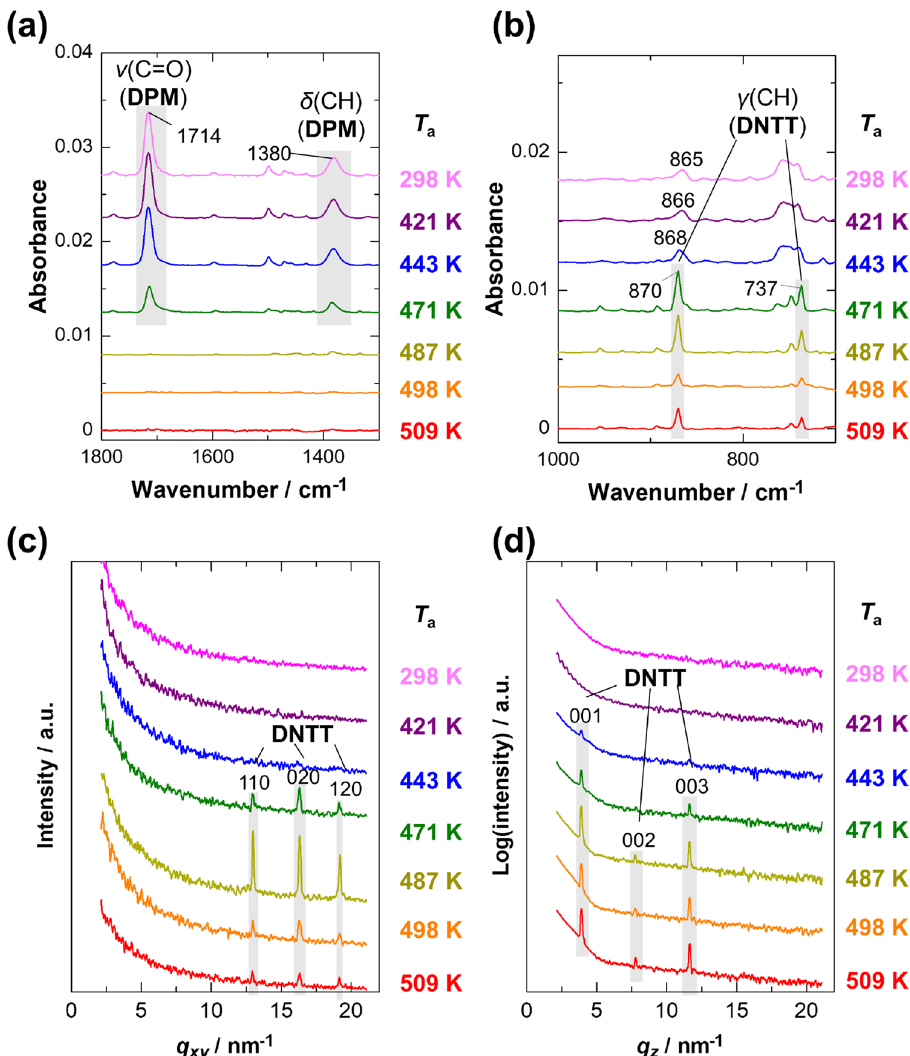
Figure 3. Orientation-free IR spectra ( a , b ), GIXD patterns ( c ), and specular XRD patterns ( d ) of endo-DPM thin films annealed for 10 min as a function of annealing temperature ( T a